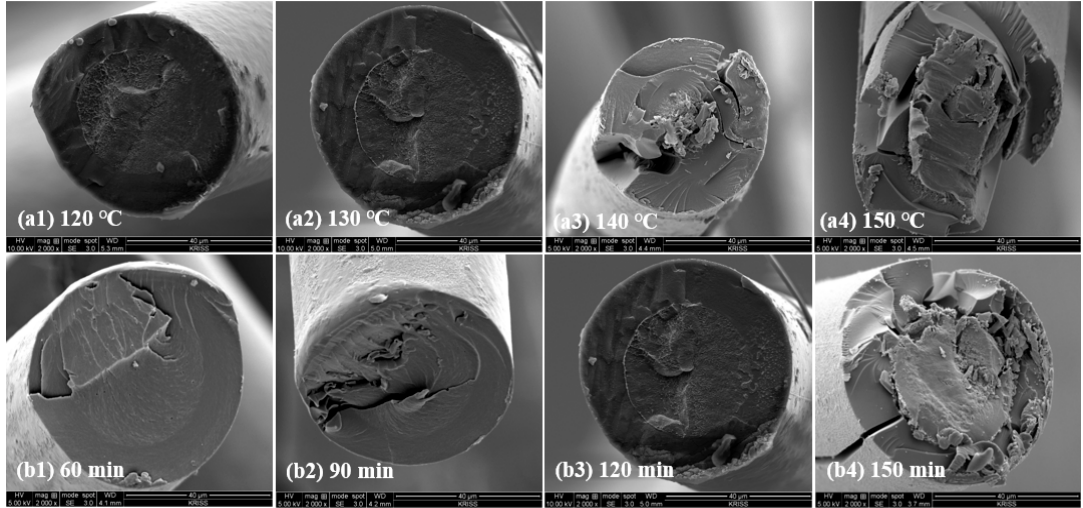
Figure 5. SEM images of the sulfonated LDPE/HDPE sheath-core fibers at various crosslinking temperature and time: ( a1 – a4 ) temperatures of 120–150 °C under 0.25 MPa for 120 min; ( b1 – b4 ) duration times of 60–150 min under 0.25 MPa at 130 °C.